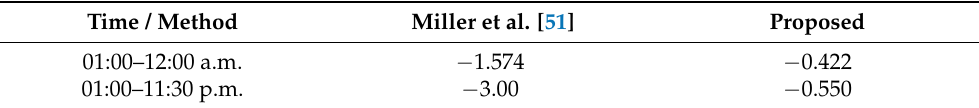
Table 3. Elasticity